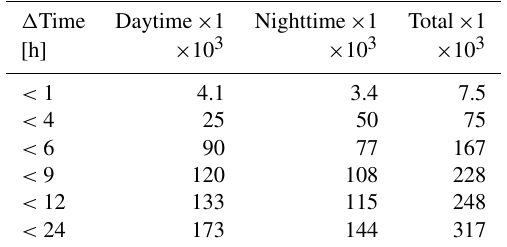
Table 2. Number of collocated cases for (cid:49) dist < 1 ◦ and different (cid:49) time